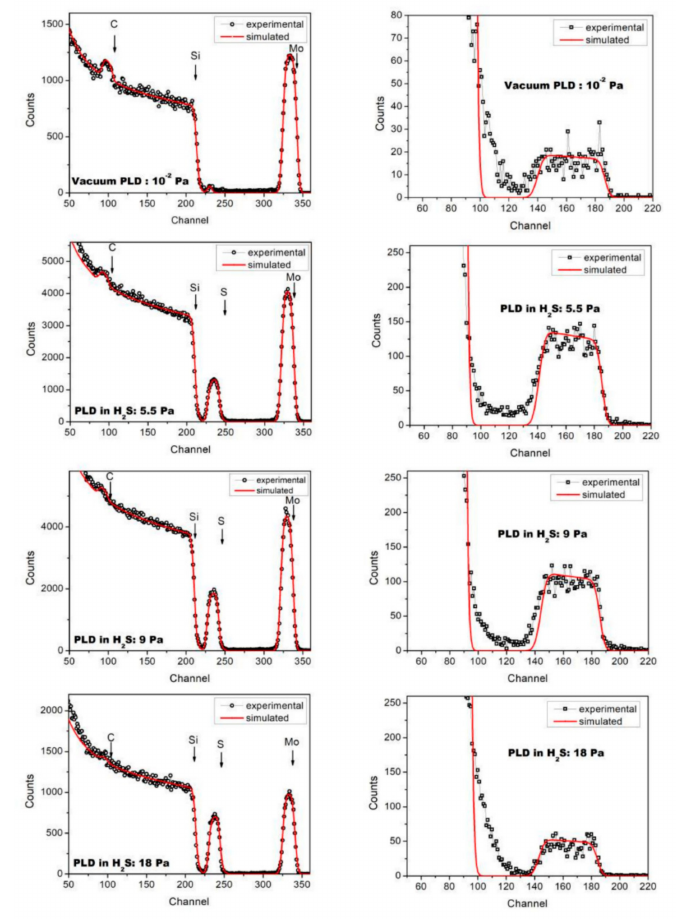
Figure 1. Experimental and simulated RBS ( left ) and ESDA ( right ) spectra of the films prepared on Si substrates by pulsed laser co-deposition of carbon and molybdenum under vacuum conditions (residual gas pressure was ~10 − 3 Pa) and in H 2 S gas with di ff erent pressures. The RBS spectrum of the film deposited in vacuum contains a peak at the channel number 230. This peak is due to scattering of ions by sulfur atoms that have been adsorbed on the surface of the Si substrate before the film